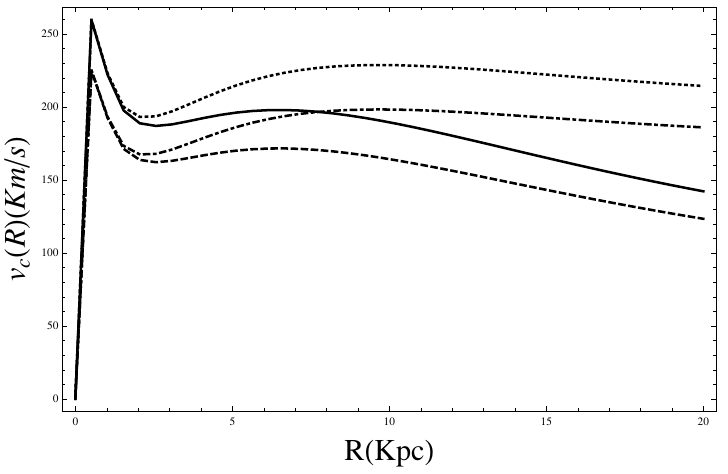
Figure 6. The global rotation curve in the framework of GR (dashed line), GR + DM (dashed and dotted line), FOG (solid line) and FOG + DM (dotted line). The values of “masses” are µ = 10 − 2 a − 1 and µ = 10 2 a − 1 1 2